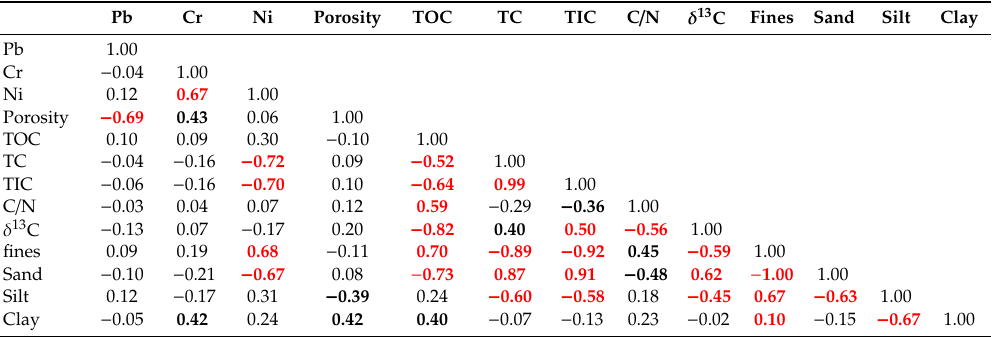
Table 1. Linear correlation coe ffi cients between Pb, Cr and Ni concentrations ( µ g / g), porosity, organic carbon (TOC, %), total carbon (TC, %), inorganic carbon (TIC, %), C / N ratio, carbon stable isotope ( δ 13 C, % (cid:24) ) and sediment compositions (fines, sand, clay, silt contents, %). Statistically relevant coe ffi cients are reported in bold and highly significant one in bold